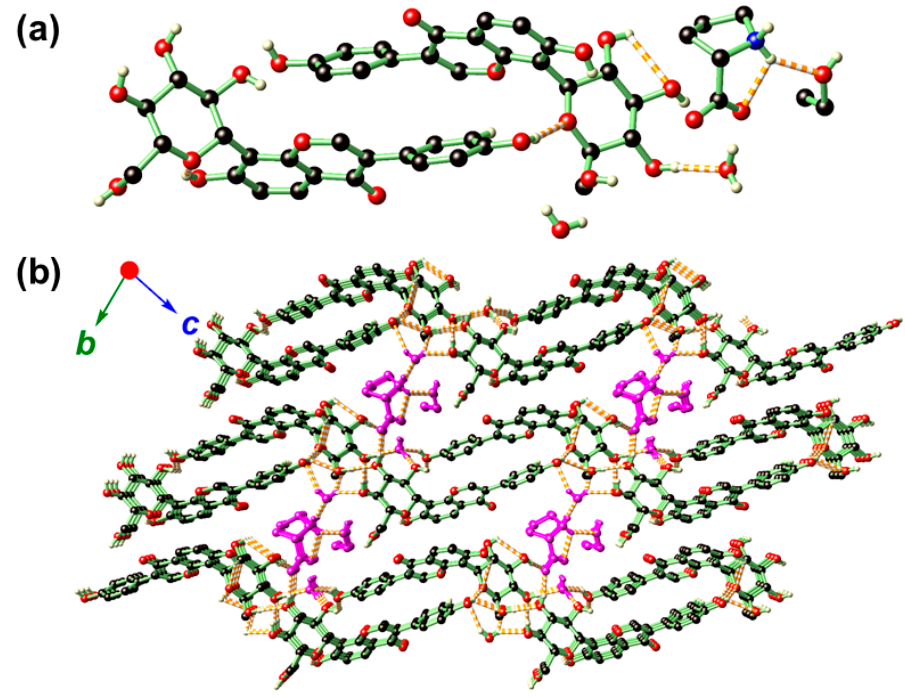
Figure 3. The asymmetric unit ( a ) and hydrogen-bonding network ( b ) of II . In b, the structure is propagated along the crystallographic b and c directions showing that PRO, one EtOH, and a pair of H 2 O molecules are sandwiched in-between the layers generated by PUE. The PRO and crystalline solvates were distinguished by dark magenta for clarity purposes. Color codes: O (red), N (blue), C (black), H (light yellow).